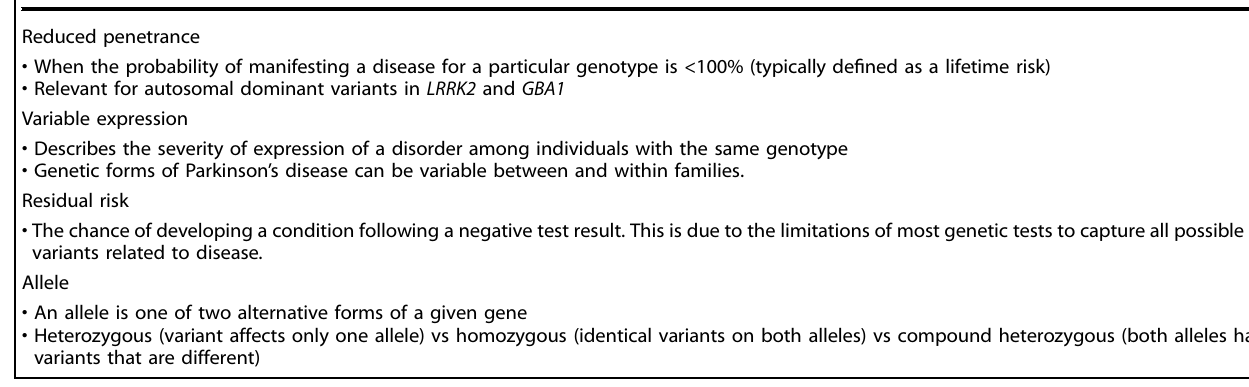
Table 4. Important genetic terms for PD risk communication. Reduced